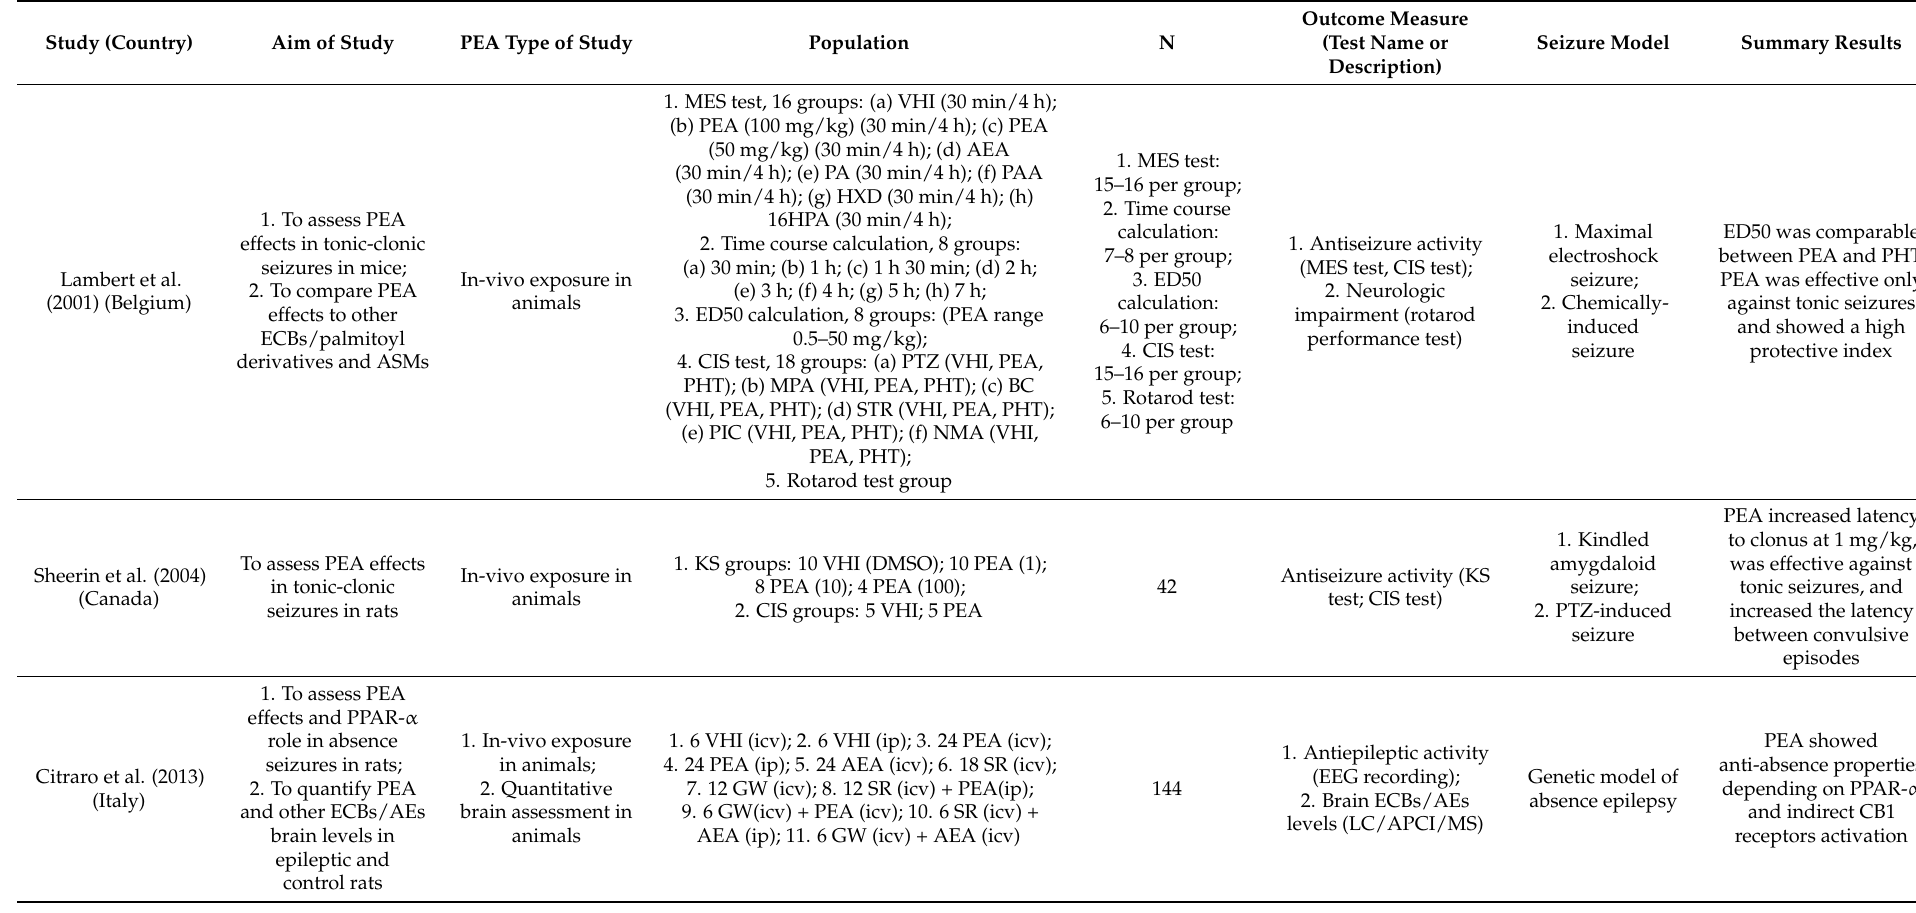
Table 1. Summary of studies investigating palmitoylethanolamide and its correlations to epilepsy and acute